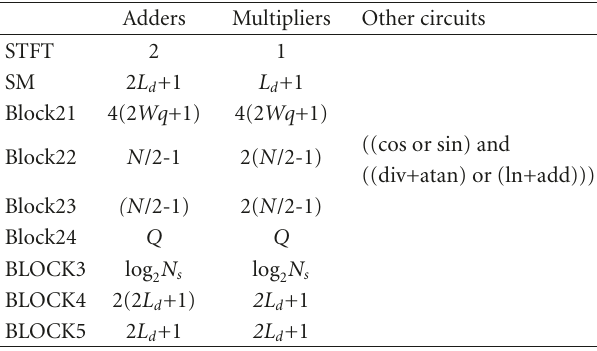
Table 4: The longest path of serial realization.